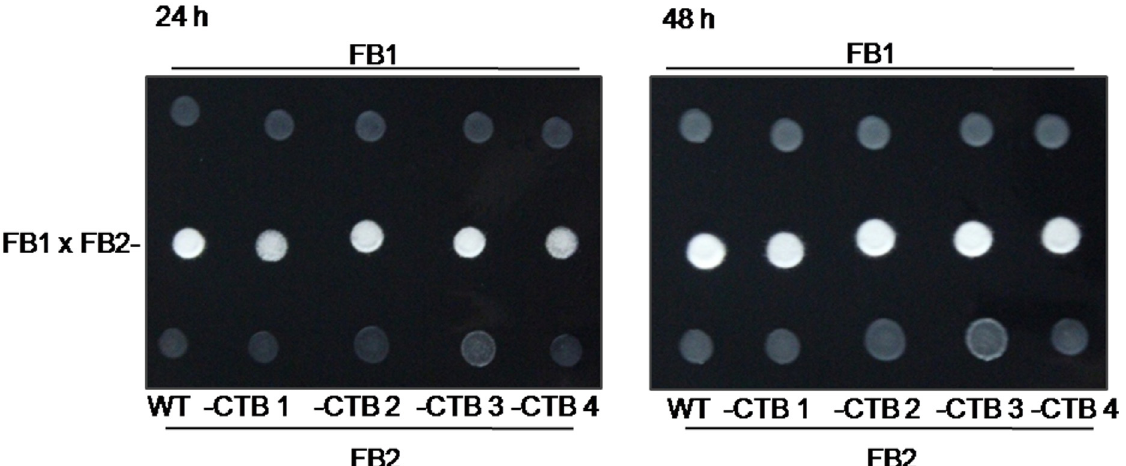
Fig 2. U . maydis FB2-CTB strains develop fuzzy colonies when are paired withthe FB1 strain. FB2-CTB transformants were co-spotted with their mating partner FB1 strain on a charcoal-containing MM plates. The FB2 x FB1 cross was tested as control. Photos were taken 24 and 48 h after incubation at room temperature.